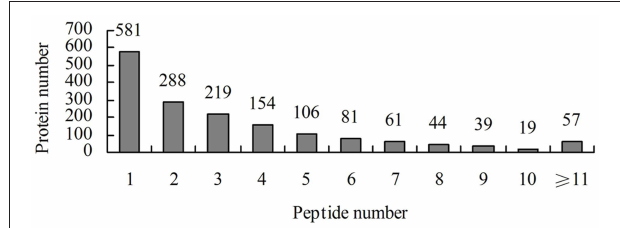
FIGURE 2 | Number of peptides that were matched to proteins using MASCOT.